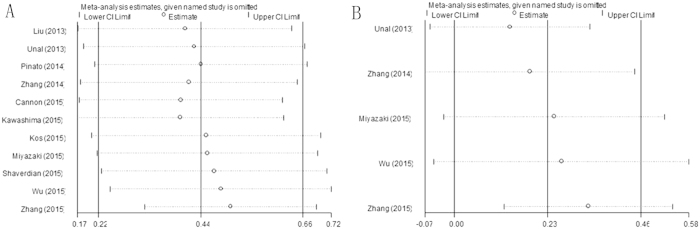
Sensitivity analysis on the relationship between PLR and (A) OS and (B) DFS/PFS in NSCLC.